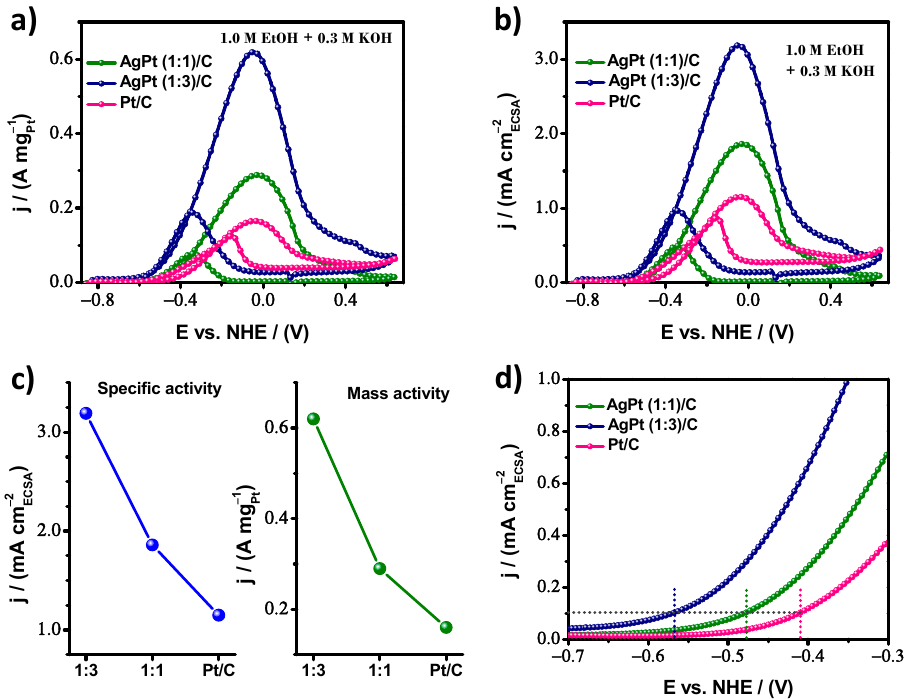
Figure 6. Cyclic voltammograms in 0.3 M KOH + 1.0 M ethanol solution at 20 mV s − 1 normalized for ( a ) mass activity (MA), ( b ) specific activity (SA), ( c ) mass activity (MA) and specific activity (SA) at the maximum point of the reaction rate, and ( d ) close-up of the initial region of the ethanol oxidation for AgPt (1:1)/C, AgPt (1:3)/C, and Pt/C electrocatalysts.